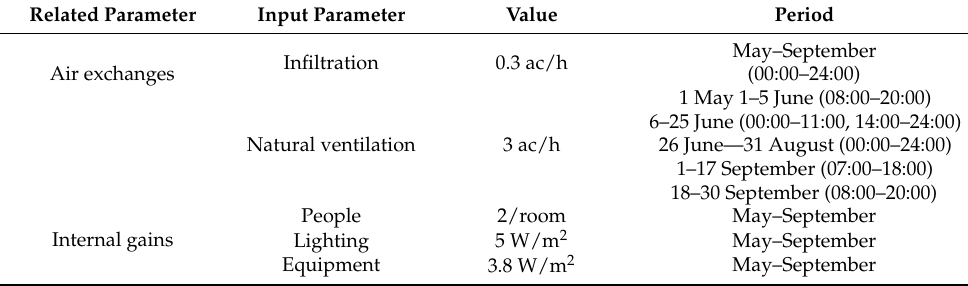
Table 4. Ventilation and internal gain settings of the simulation